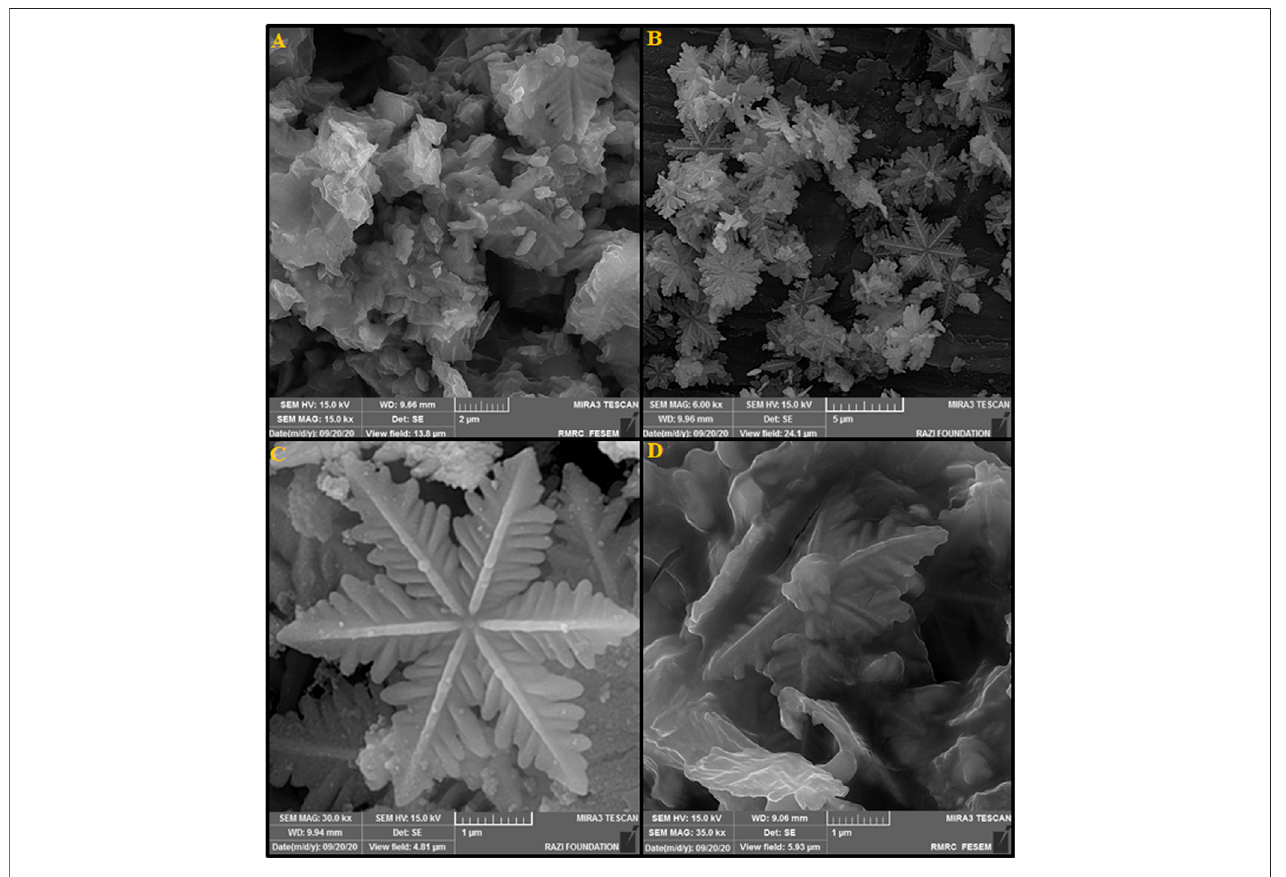
FIGURE 1 | FESEM images of the La 2 O 3 NP@SF-L Cu 2 S NS composite under various reaction temperatures: (A) 70 ° C, (B,C) 80 ° C, and (D) 90 ° C.